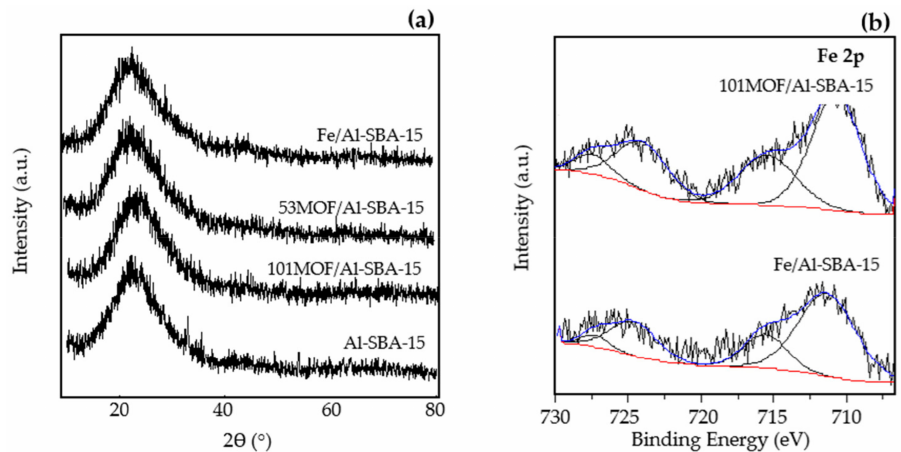
Figure 2. ( a ) Powder X-ray di ff raction patterns of Al-SBA-15, 53MOF / Al-SBA-15, 101MOF / Al-SBA-15 and Fe / Al-SBA-15 and ( b ) XPS spectra of 101MOF / Al-SBA-15 and Fe / Al-SBA-15 in Fe 2p region.